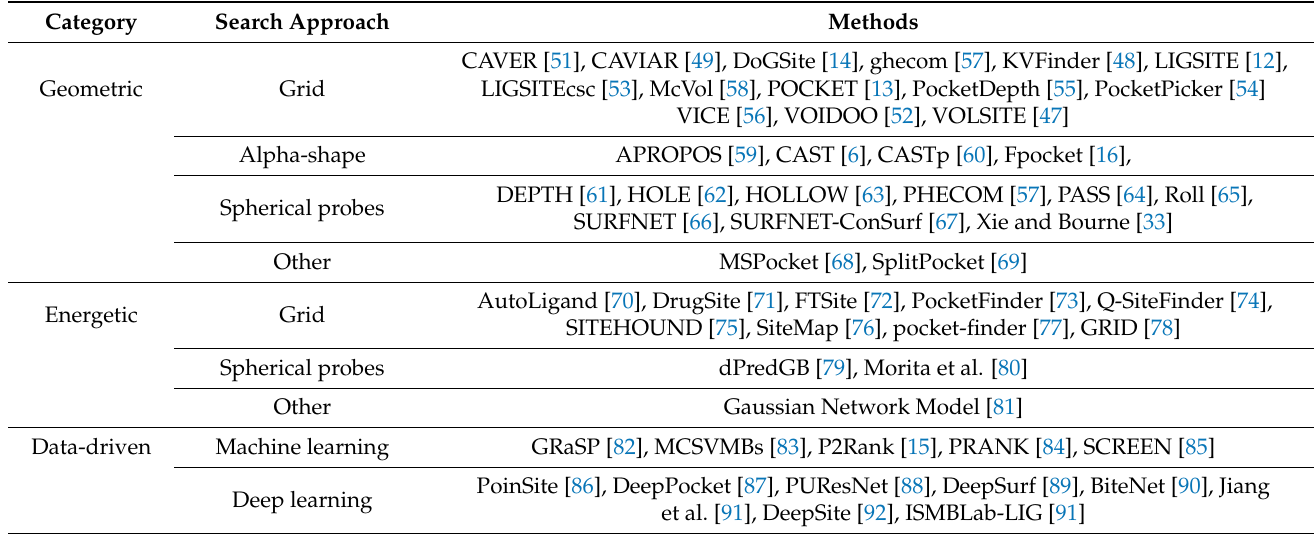
Table 1. Common structure-based methods to predict ligand binding pocket in